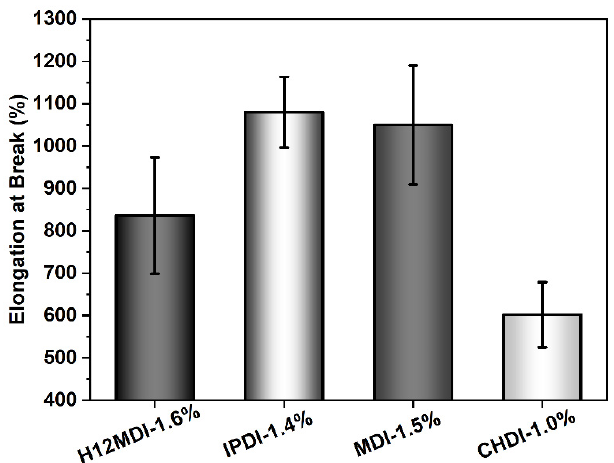
Figure 12. Elongation at break values for PSU copolymers synthesized from the aliphatic diiso-